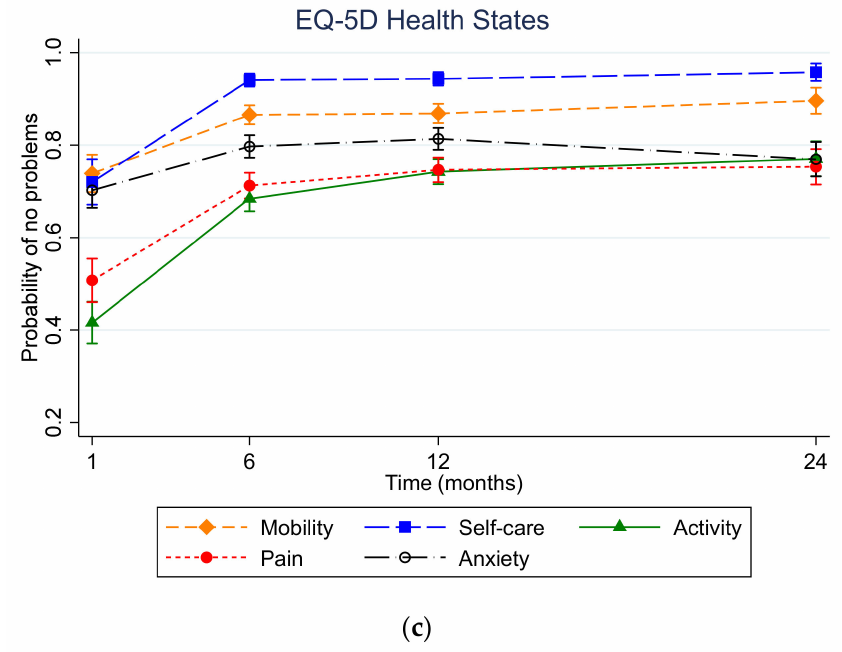
Figure 9. Predicted Margins: ( a ) EQ-5D utility score across time by sex; ( b ) EQ-5D utility score across time by age group; ( c ) EQ-5D individual health states across